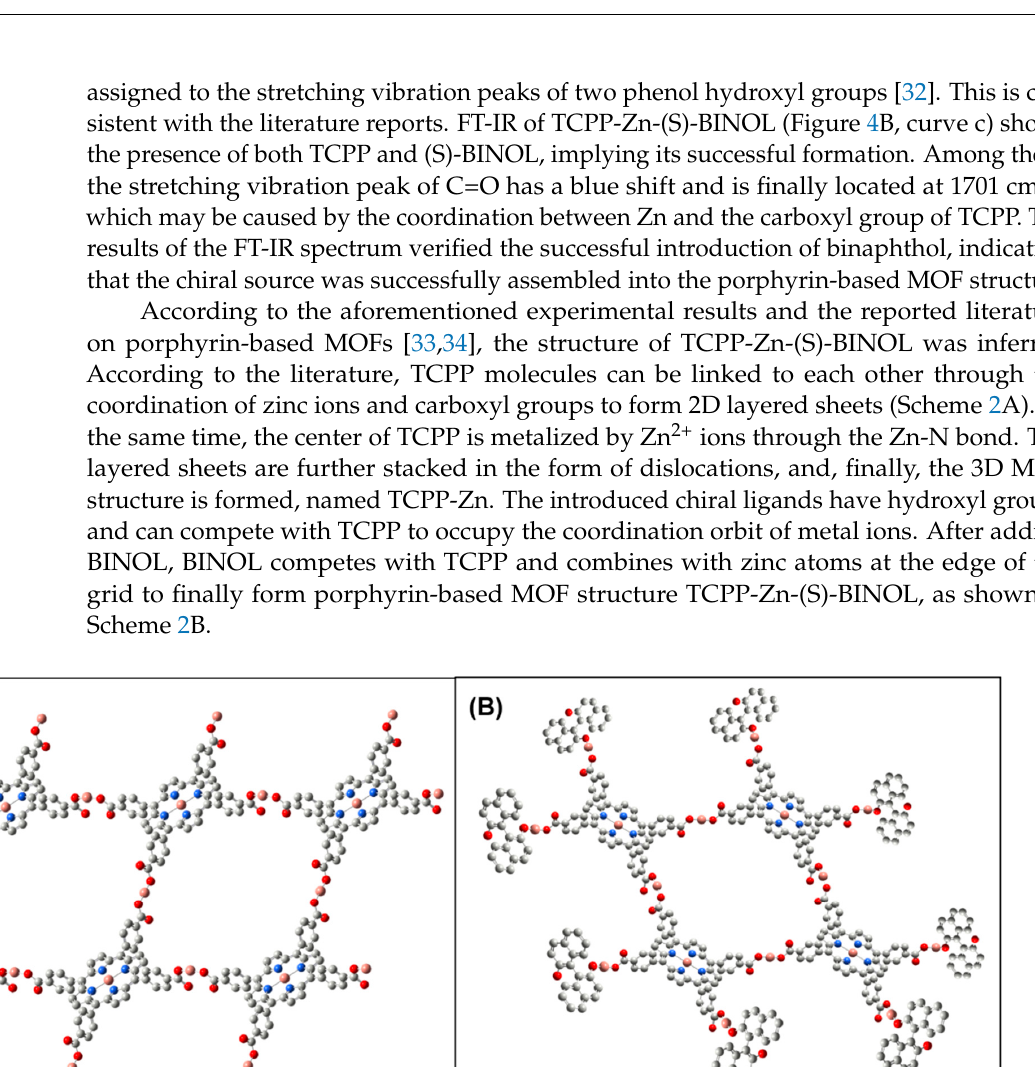
Figure 5. The optimization of ECL experimental parameters. ( A ) Effect of the pH. ( B ) The influ- ence of the weight of sample loading.